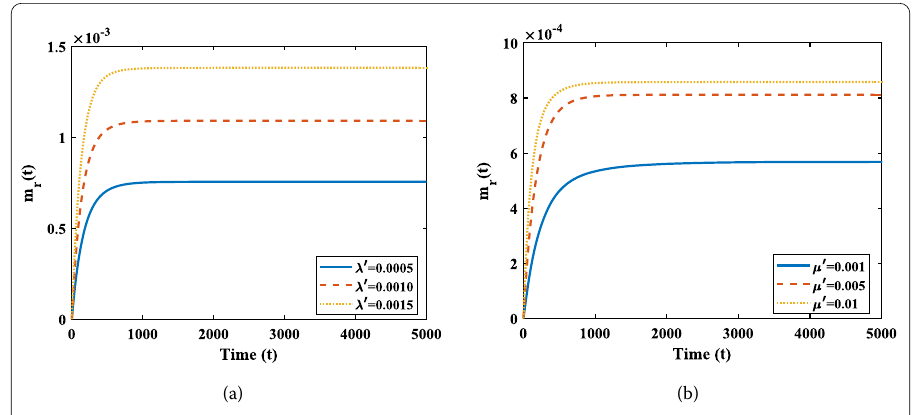
Figure 5 Effect of parameters λ (cid:2) and μ (cid:2) on time-dependent renewal frequency. ( a ) Renewal frequency for different λ (cid:2) ; ( b ) Renewal frequency for different μ (cid:2)